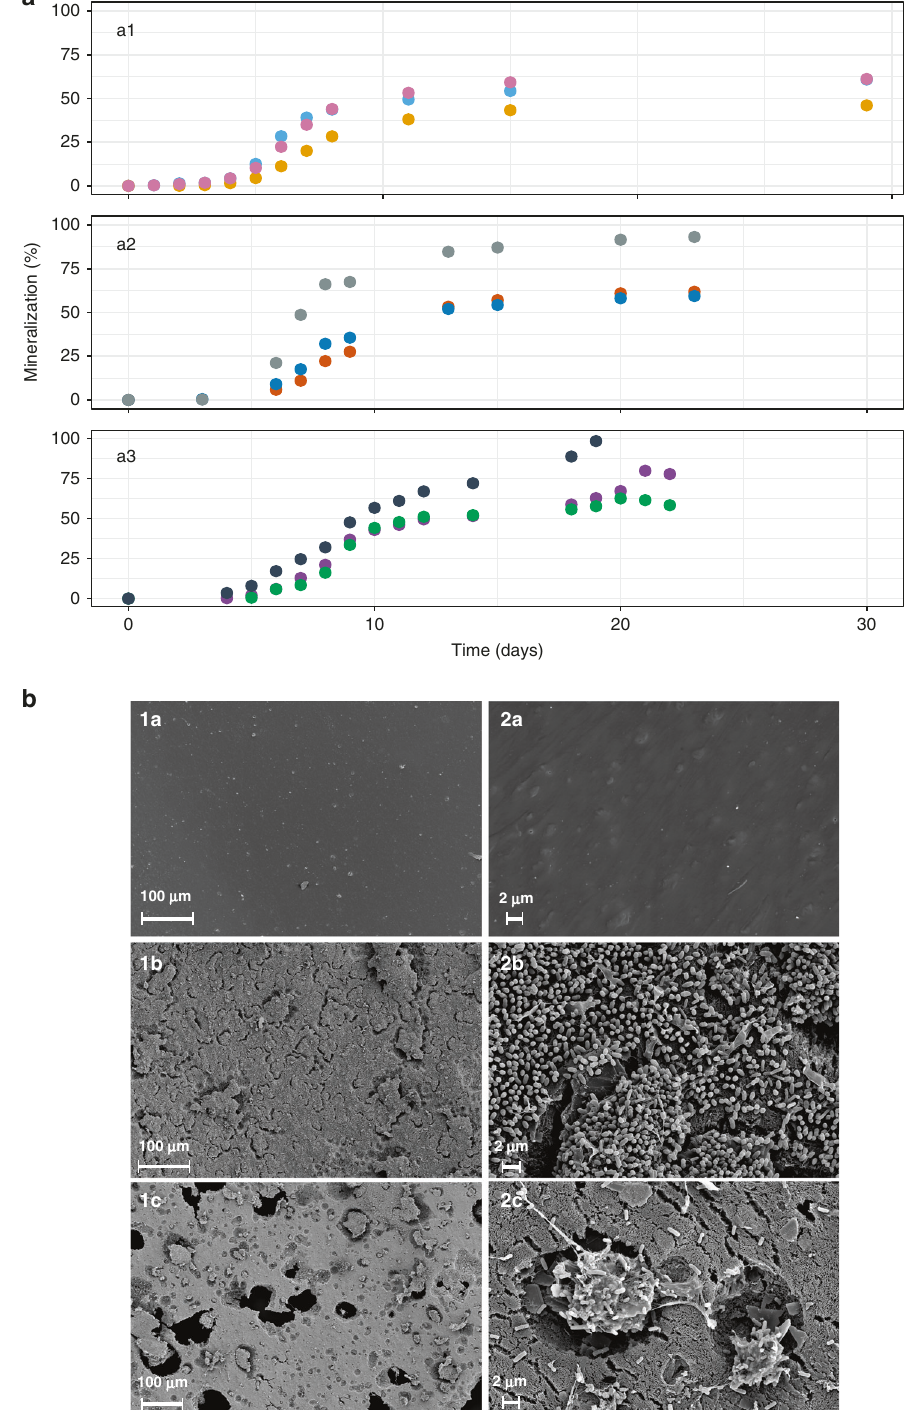
Fig. 2 Microbial growth on PF. a Mineralization and CO 2 production of PBAT-based blend fi lm (PF) by the consortia I1. Three biological replicates of three independent tests (a1, a2, a3) are shown. Each color depicts a biological replicate. b SEM image of control (1a, 2a), bio fi lm formation and plastic degradation after three days (1b, 2b) and six days (1c, 2c). The experiment was performed in two repetitions with a similar outcome. Source data are provided as a Source Data fi